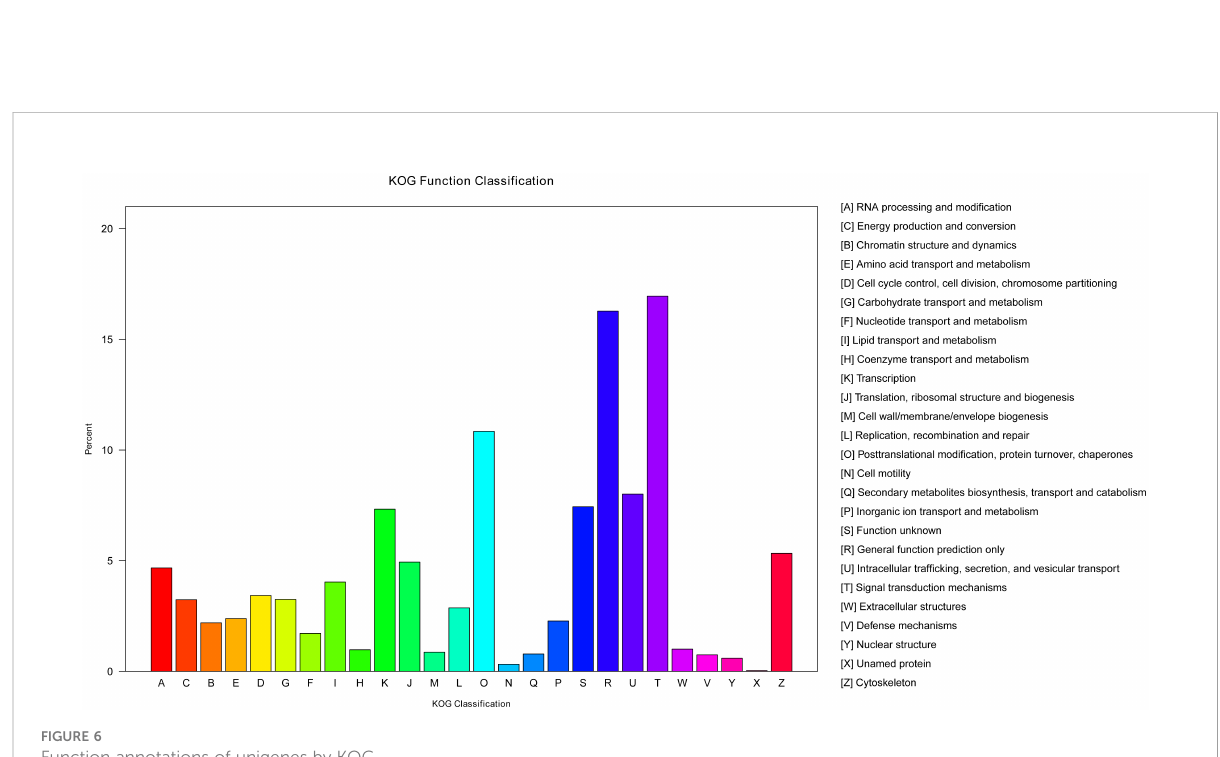
FIGURE 6 Function annotations of unigenes by KOG.